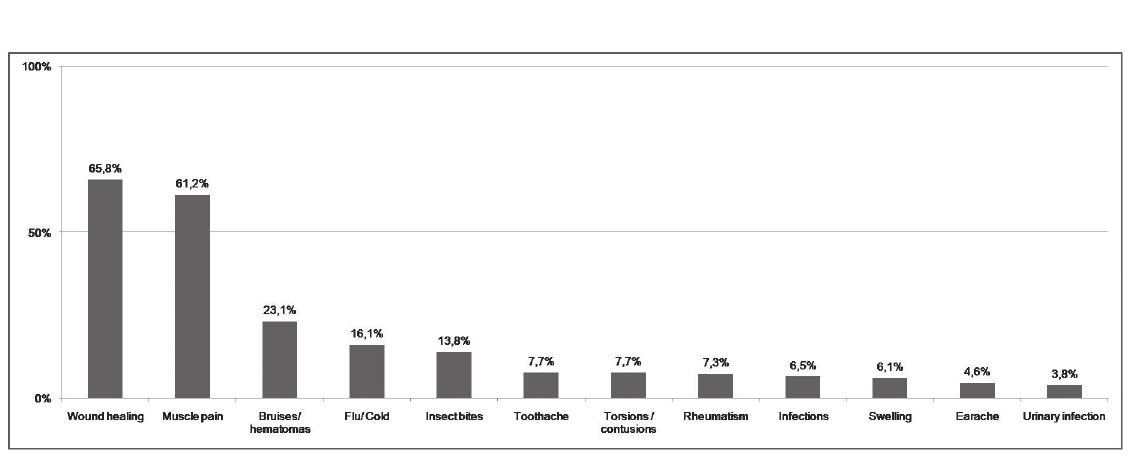
Figure 2 - Main therapeutic indications cited by C. uniflora